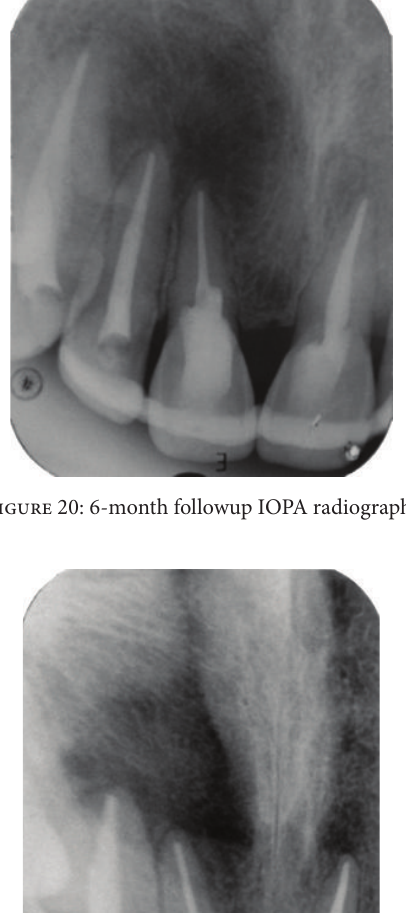
radiographs and gray scale value measurements with CBCT.